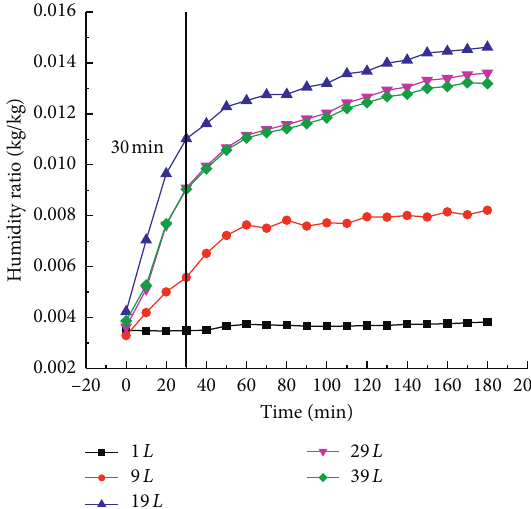
Figure 11: Analysis of the humidity ratio variations at 19 L –39 L under the condition of 200–60.